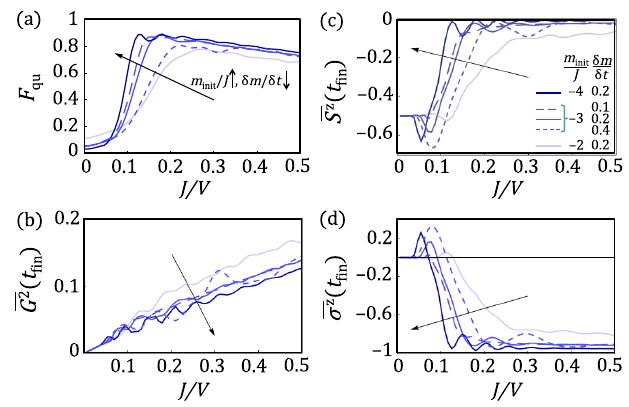
þ t(cid:8)m=(cid:8)t , init =J ¼ (cid:1) 2 , (cid:1) 3 , (cid:1) 4 init =J ¼ (cid:1) 3 init